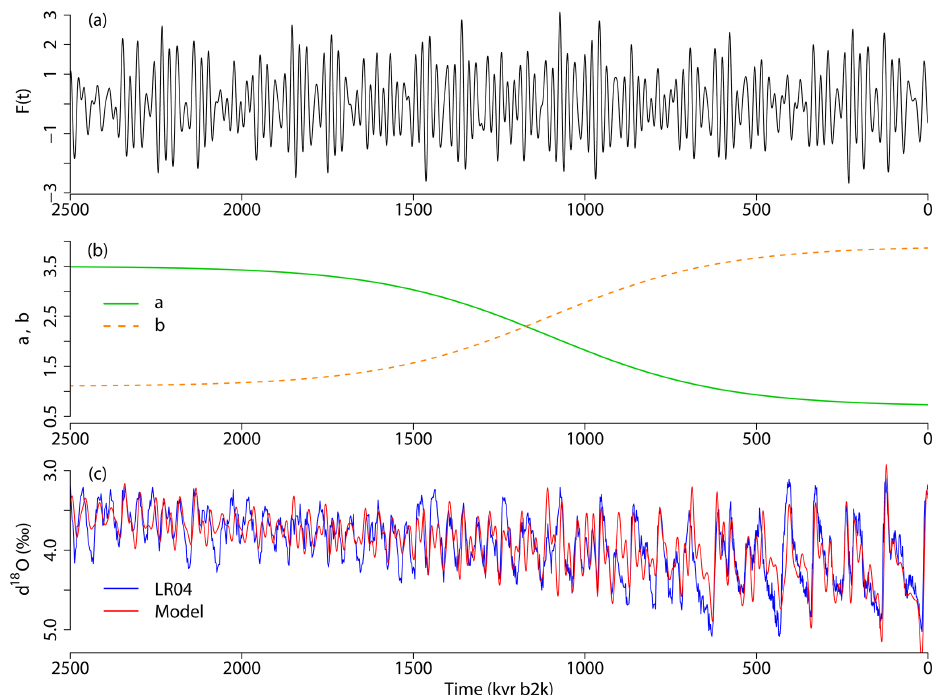
Figure 13. Glacial–interglacial cycles simulated by the modified Daruka and Ditlevsen model of Eqs. (28) and (30): (a) 21 June insolation F ( t ) at 65 ◦ N, normalized to have mean zero and unit standard deviation over the last 1000kyr, according to Laskar et al. (2004a). (b) Slowly changing parameters α ( t ) and β ( t ) introduced to give rise to the MPT. (c) Simulated glacial–interglacial cycles δ 18 O model (red) in comparison with the benthic δ 18 O data (blue); the latter dataset, provided by Lisiecki and Raymo (2005a), is also known as the LR04